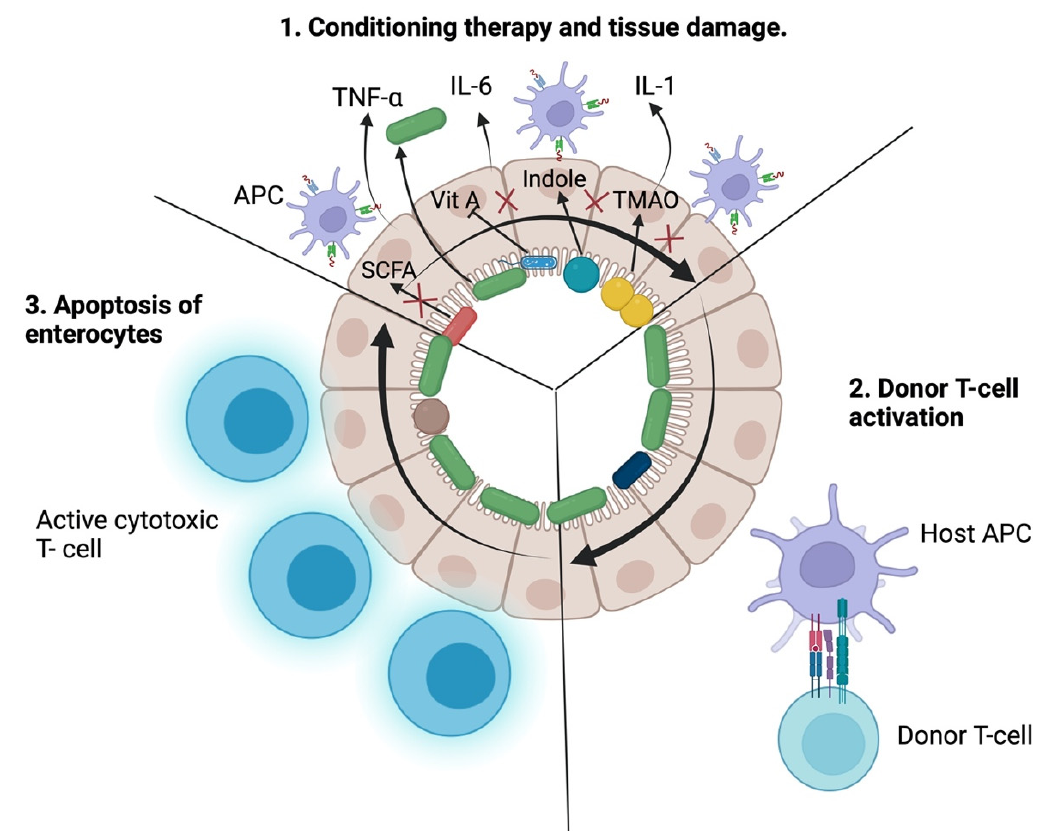
Figure 1. The role of the gut microbiota in the pathogenesis of graft-versus-host disease. During the first phase of GvHD, the conditioning therapy is accountable for tissue damage, and rapidly proliferating intestinal cells are particularly prone to the therapy. The damaged cells released TNF α , IL-6, and IL-1, which are known as “danger signals” that trigger the influx of APC. SCFA (short-chain fatty acids)-producing bacteria are frequently eliminated during the time of alloHCT because of the antibiotics used. Therefore, the lack of SCFA needed for maintaining intestinal integrity and inhibiting apoptosis of intestinal wall cells leads to the aggravation of GvHD. Lack of intestinal integrity results in the transfer of bacteria to the bloodstream, which can cause sepsis. Moreover, the indole that is produced by commensal microbiota is also known to play a role in maintaining intestinal integrity. TMAO (choline-derived trimethylamine N-oxide) has been shown in the mouse model to promote the differentiation of Th17 cells, which facilitates GvHD. Additionally, the level of vitamin A seems to be negatively correlated with the severity of alloHCT, and some gut microbes are known for preventing retinoid metabolism. The gut microbiota of patients with aGvHD is of poor diversity. During the second stage, the host APC presents antigens to the donor T cells, stimulating robust annihilation of the enterocytes in phase 3, which in turn leads to further aggravation of the disease.